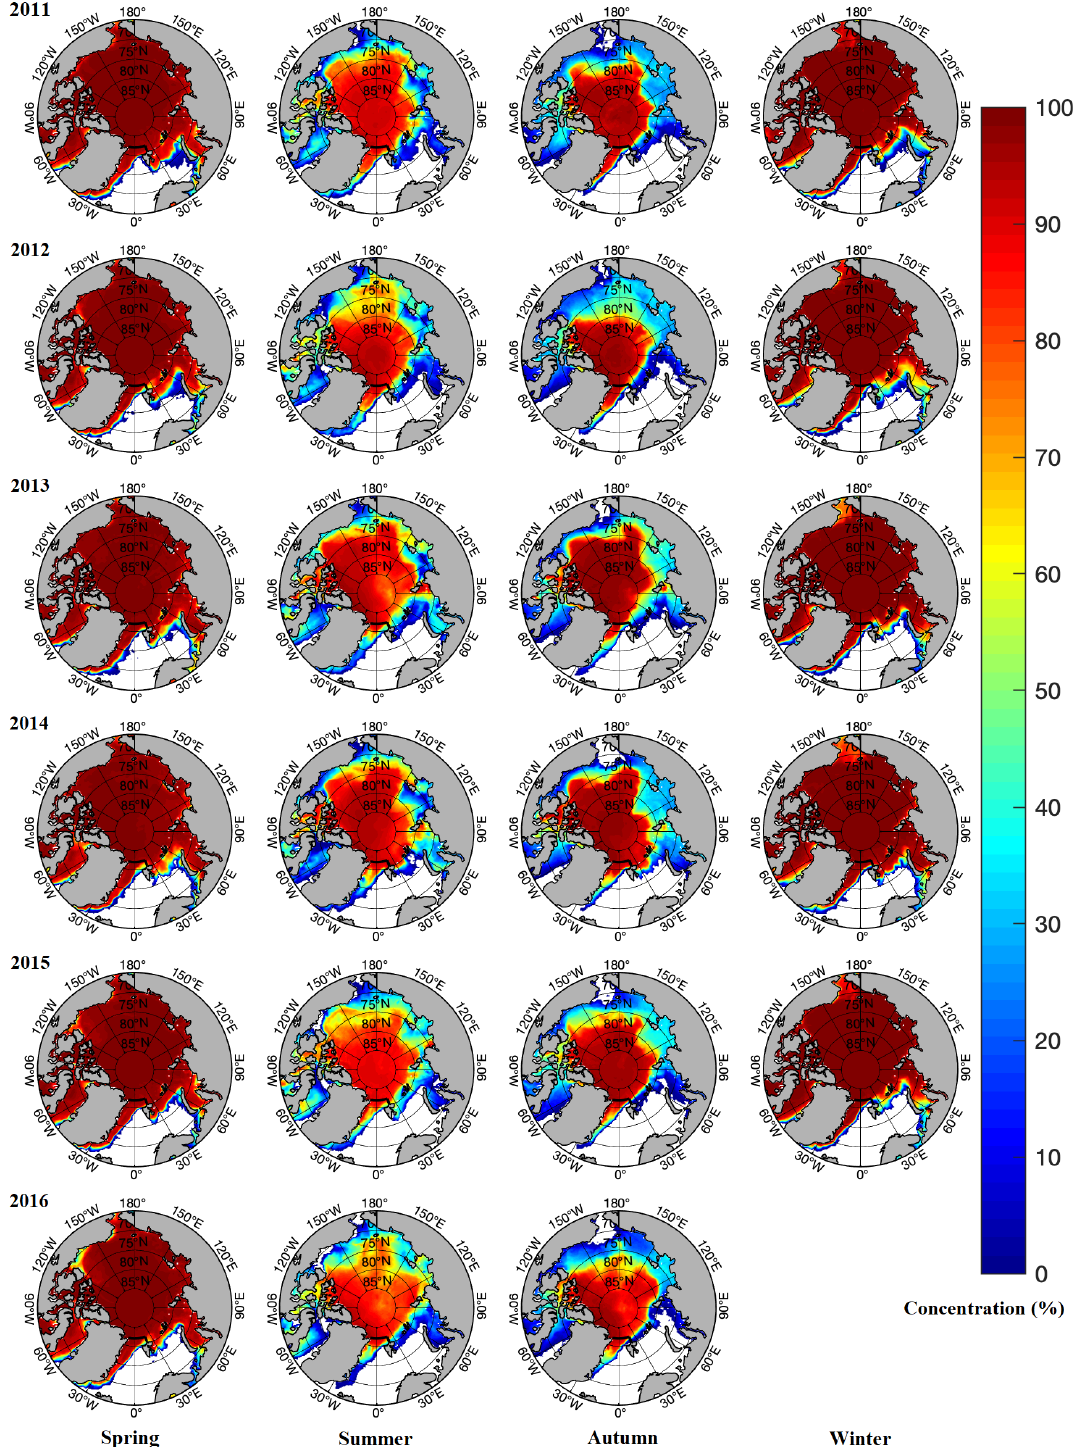
Figure 4. Seasonal variation in Arctic sea ice concentration. The thick black line represents the sea ice flux gate in the Fram Strait.